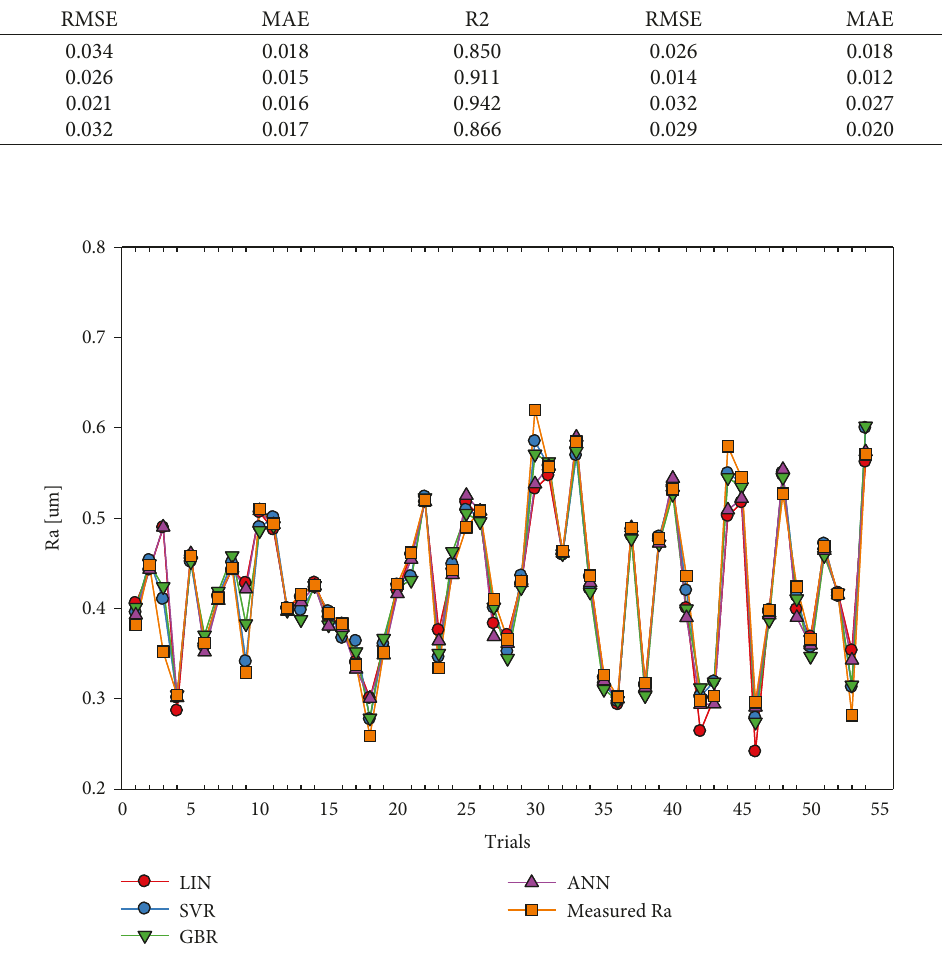
Figure 8: Comparison of experimental measurement and prediction of Ra on the training